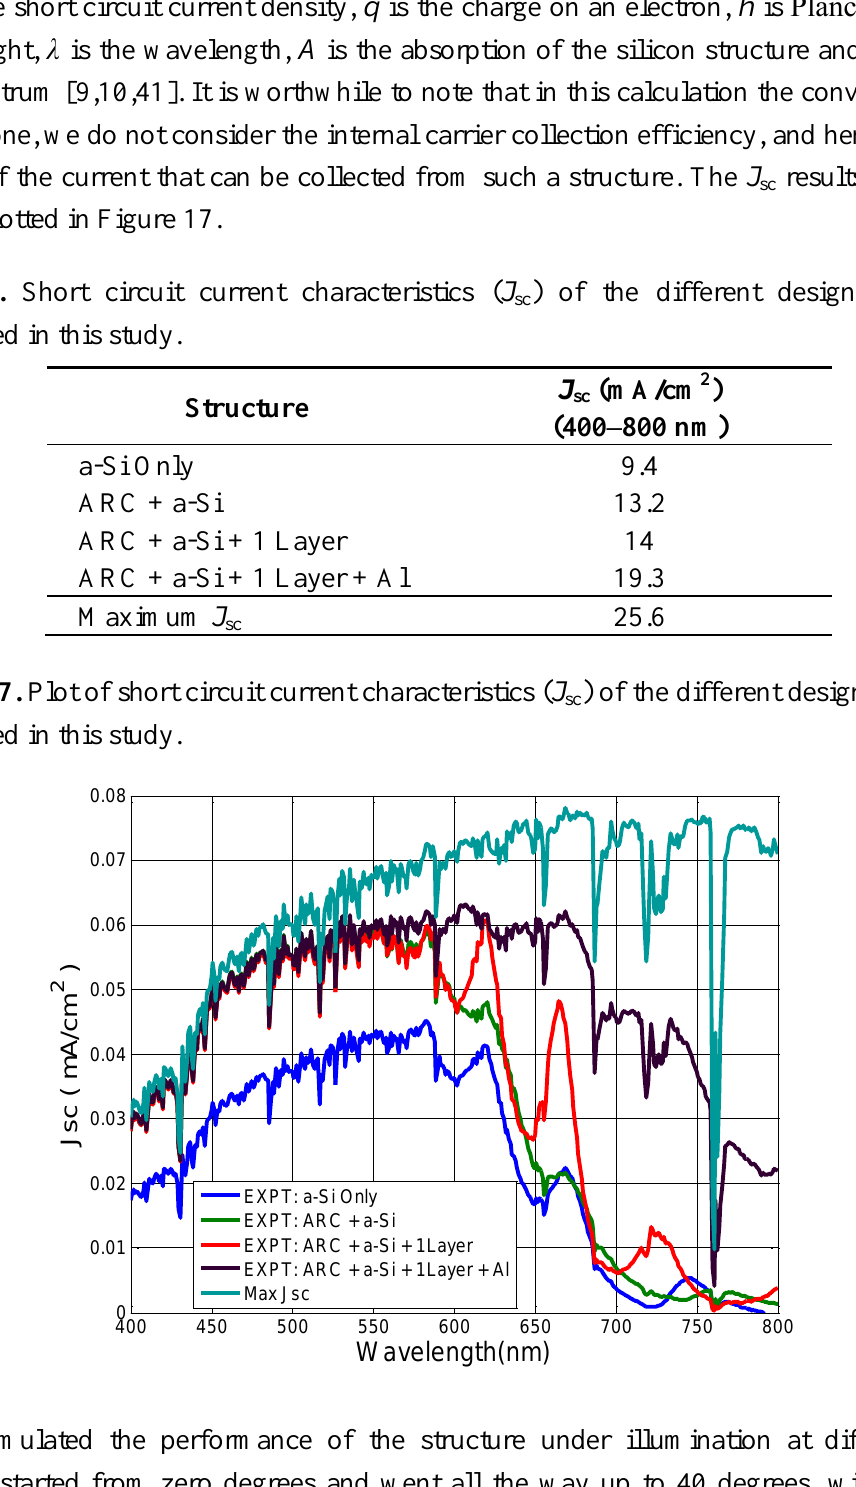
) of the different design structures sc